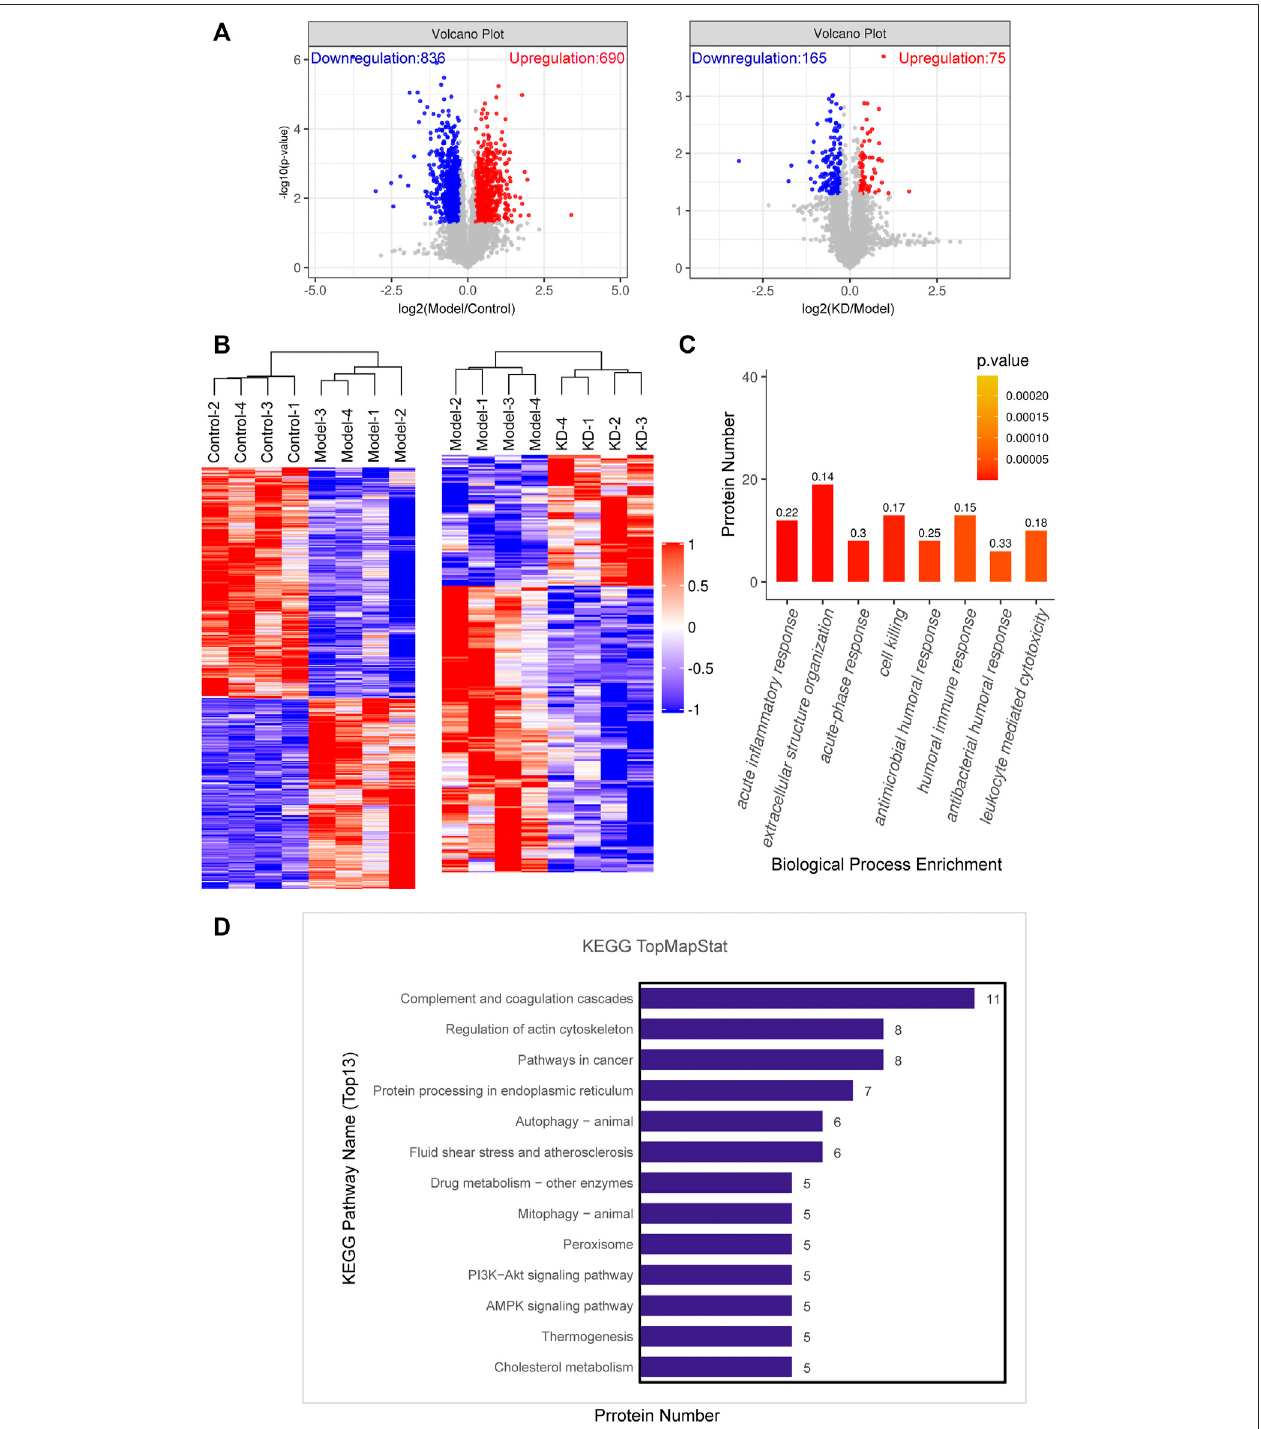
FIGURE 3 | Data from proteomic analysis of mice liver tissue. (A) Volcano plots of the number of differentially expressed proteins between the model and control groups and the KD and model groups. (B) Cluster analysis of the differentially expressed proteins in the control, model, and KD-treated groups of mice. (C) Biological process classi fi cation of GO functional enrichment histogram between the KD and model groups. The numbers on the histogram represent rich factor. The rich factor representstheratioofthenumberofdifferentiallyexpressedproteinsannotatedtoaGOfunctionalcategorytothenumberofallidenti fi edproteinsannotatedtothe GO functional category. (D) KEGG pathway annotation of the top 13 differentially expressed proteins between the KD and model groups. ( n (cid:1) 4).